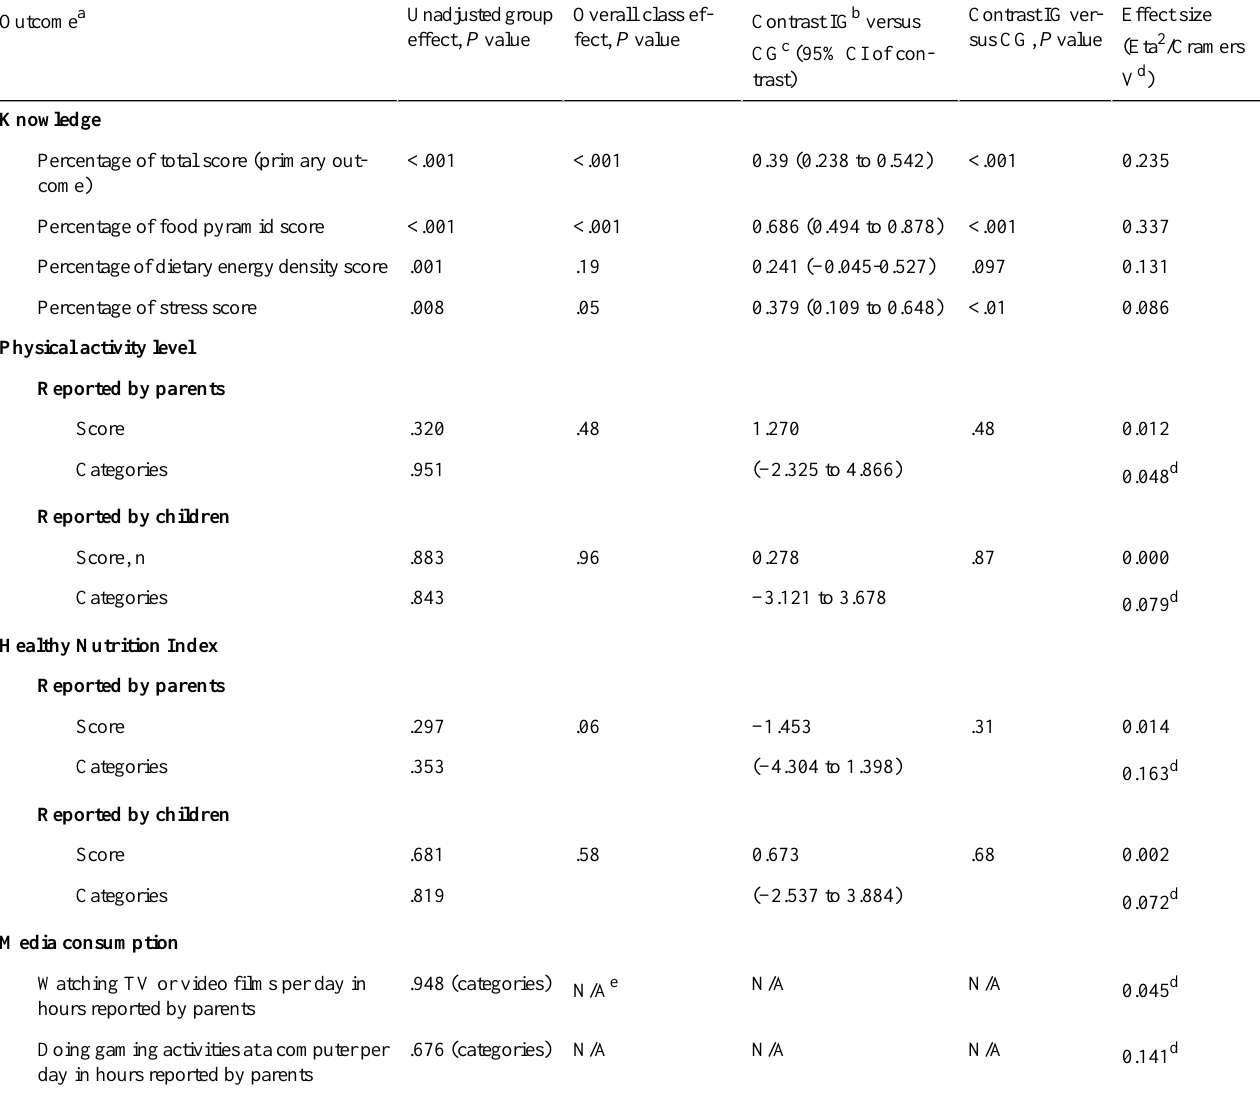
Table 3. Complete overview of statistics from the intention-to-treat